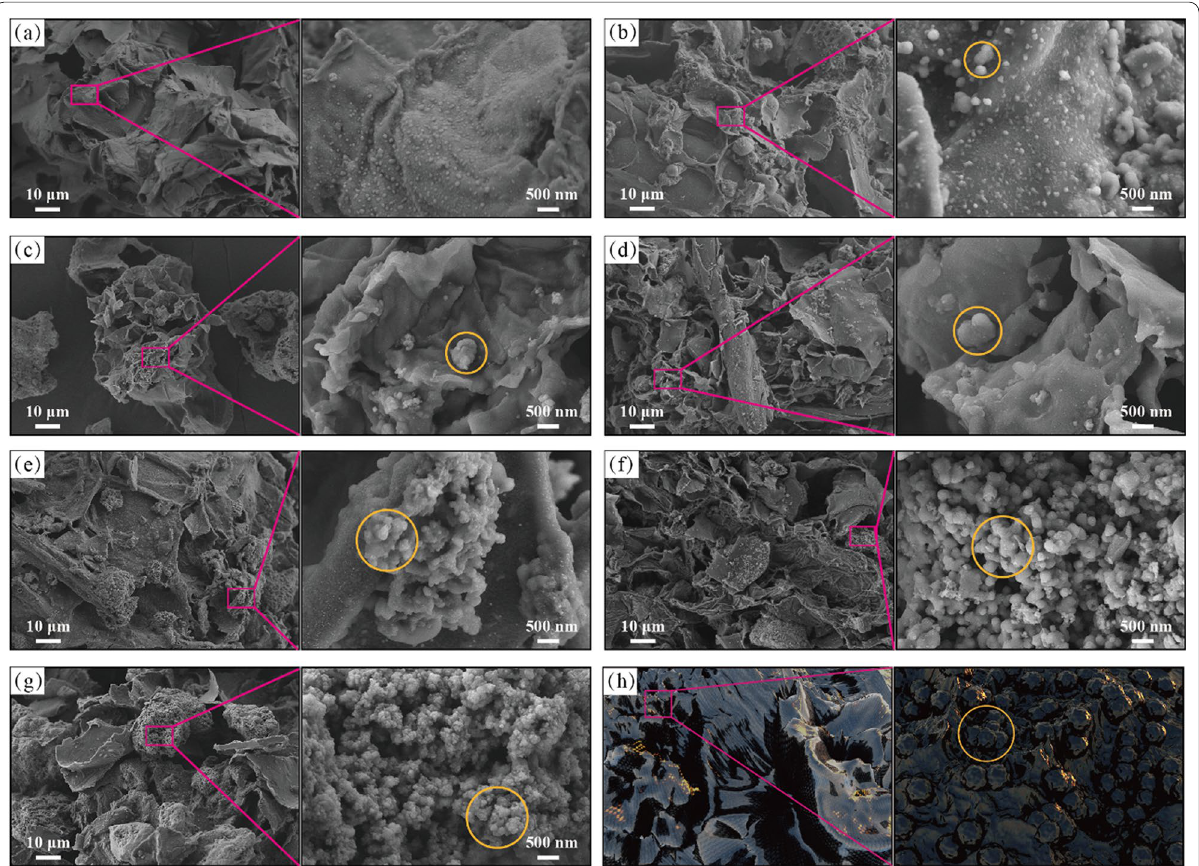
Fig. 2 SEM images of a BC and b – g AFFA/BC (AFFA 200 /BC, AFFA 200 -NA/BC, AFFA 200 -DW/BC, AFFA 600 /BC, AFFA 600 -NA/BC, and AFFA 600 -DW/BC, respectively); h structure modeling of